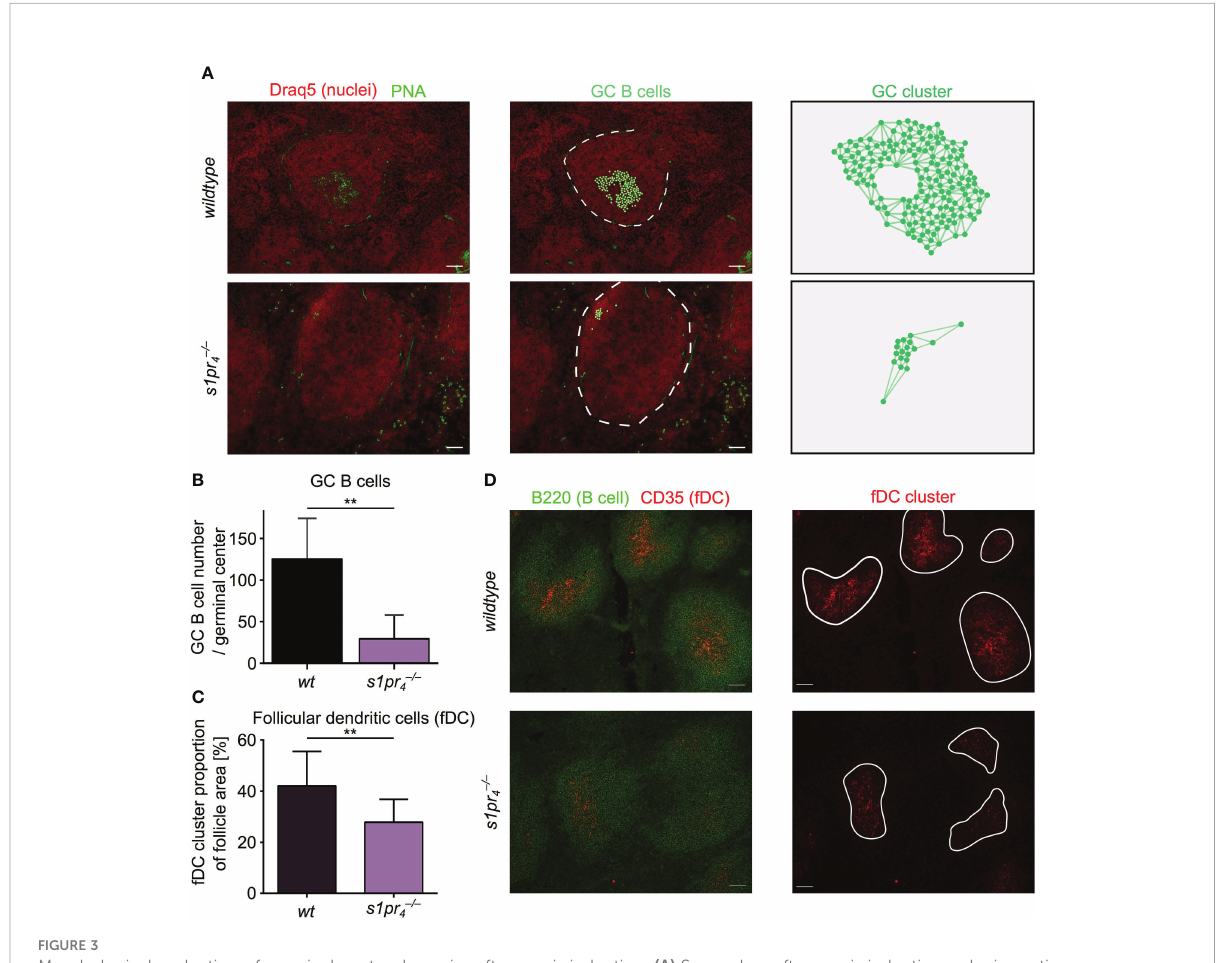
FIGURE 3 Morphological evaluation of germinal center dynamics after sepsis induction. (A) Seven days after sepsis induction, splenic sections were analyzed for the presence of germinal center (GC) using PNA (green). GC B cells were automatically segmented and cluster analysis was performed using QuPath. (B) GC from s1pr − = − 4 mice were signi fi cantly smaller and showed excentric localization, when compared to wt counterparts. (C, D) Follicles were analyzed for the presence of CD35 + follicular dendritic cells (FDC). FDC clusters were present in both genotypes, although cluster size was decreased in s1pr − = − 4 mice. All images representative for at least n = 3 animals per group. White scale bar equals 50 µm. **p <